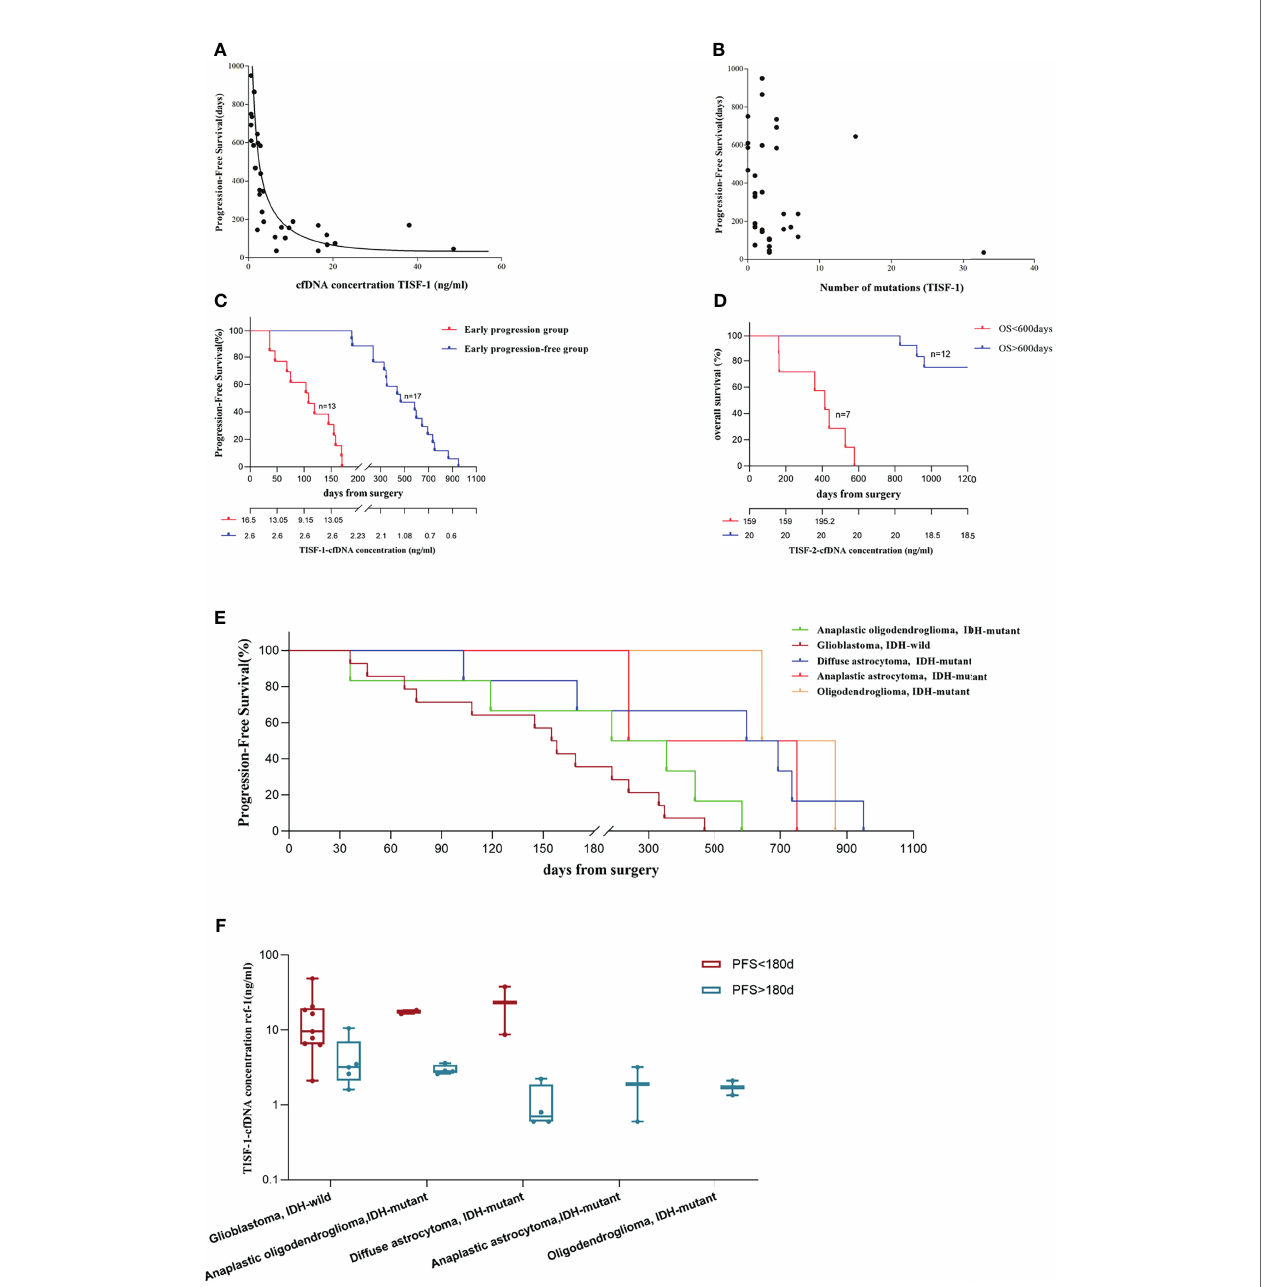
FIGURE 6 | Analysis of tumor DNA derived from TISF and patient survival. (A) cfDNA concentration was inversely correlated with patients ’ PFS (p < 0.001, Spearman ’ s rank correlation coef fi cient r = − 0.844). (B) There was no correlation between the number of mutations in TISF-1 and patients ’ PFS. (C) Progression-free survival in the early progression group and the early progression-free group. And the median cfDNA concentration at each time point. (D) Overall survival of 19 patients. (E) Progression-free survival of gliomas was observed for each pathological type. (F) For each pathological type of glioma, cfDNA concentration was still signi fi cantly higher in the early progression